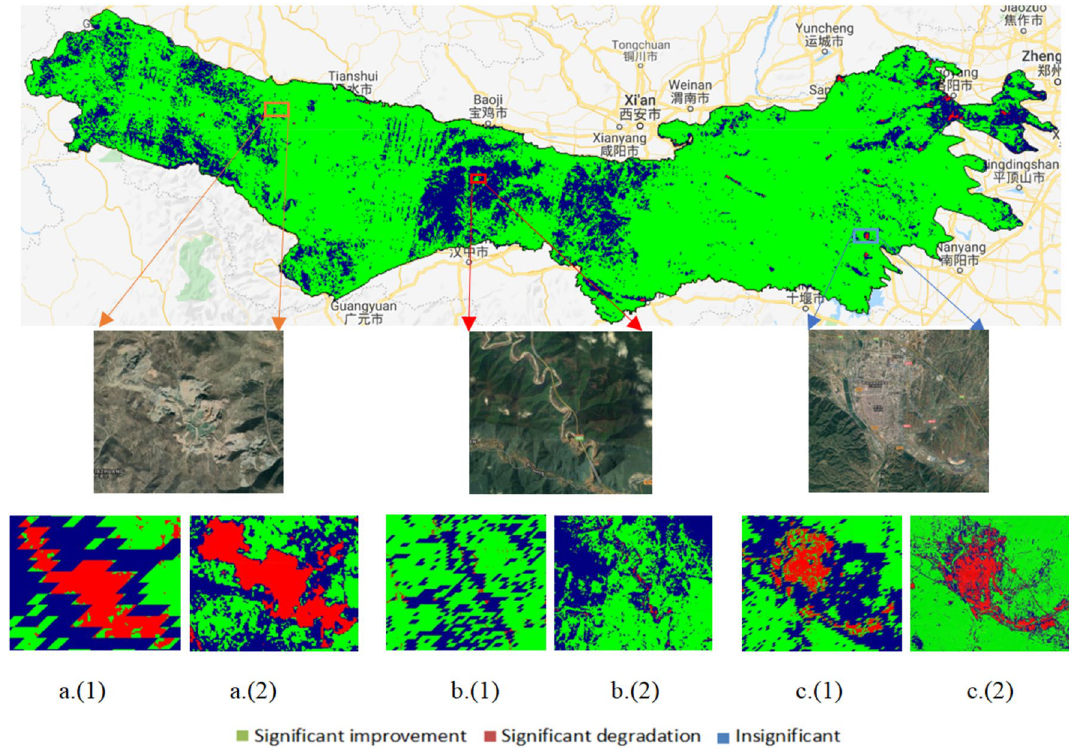
Figure 6. The significant change of NDVI from 2000 to 2018 in Qin Mountains. Numbers (1) and (2) refer to the NDVI derived from the MODIS and Landsat dataset based on the GEE (https ://earth engin e.googl e.com/), respectively. Considering to compare the difference between MODIS and Landsat, we calculated significant change of NDVI based on the two datasets by using same method (Theil–Sen Trend). Meanwhile, we choose the area with vegetation degradation such as residential, transport area, and mining area to further compare this